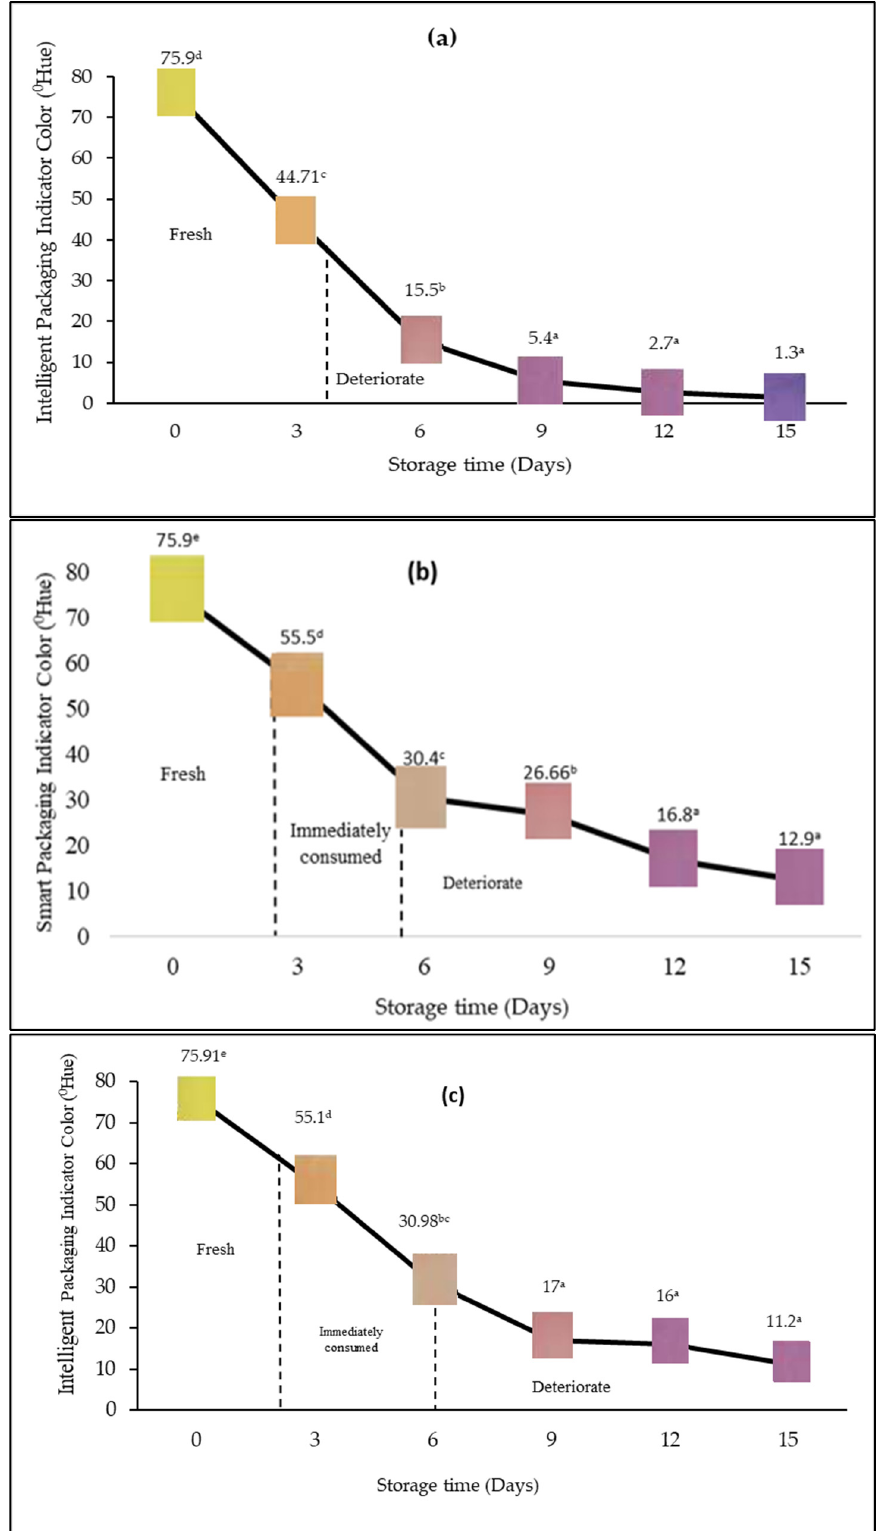
Figure 3. Change in the color of the intelligent packaging indicator for the packaged product. ( a ) Indicator label with the addition of 0% garlic extract, ( b ) indicator label with the addition of 15% garlic extract, and ( c ) indicator label with the addition of 20% garlic extract. The mean value followed by various letters indicates a significant difference ( p < 0.05).